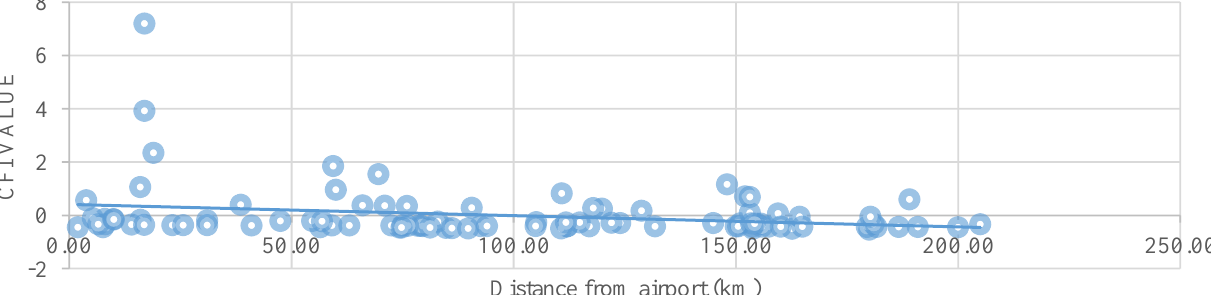
Figure 9. Change in CFI with respect to distance from airport .